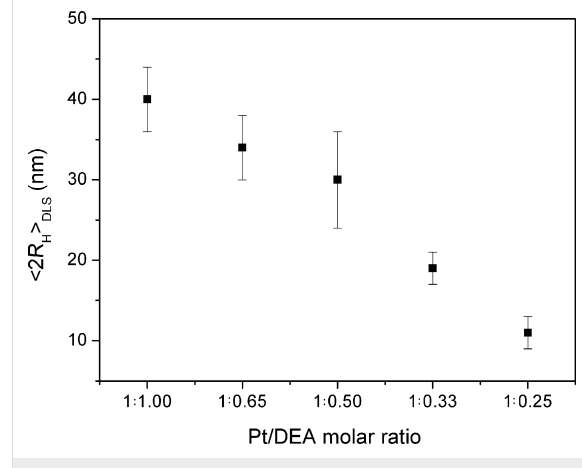
Figure 2: 2 Influence of Pt/DEA molar ratio: DLS results in water.